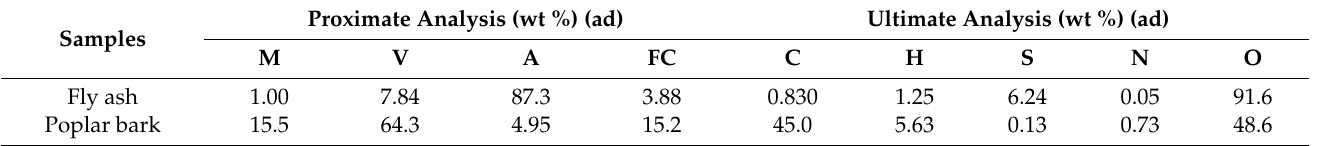
Table 1. Proximate and ultimate analysis results of the raw materials.